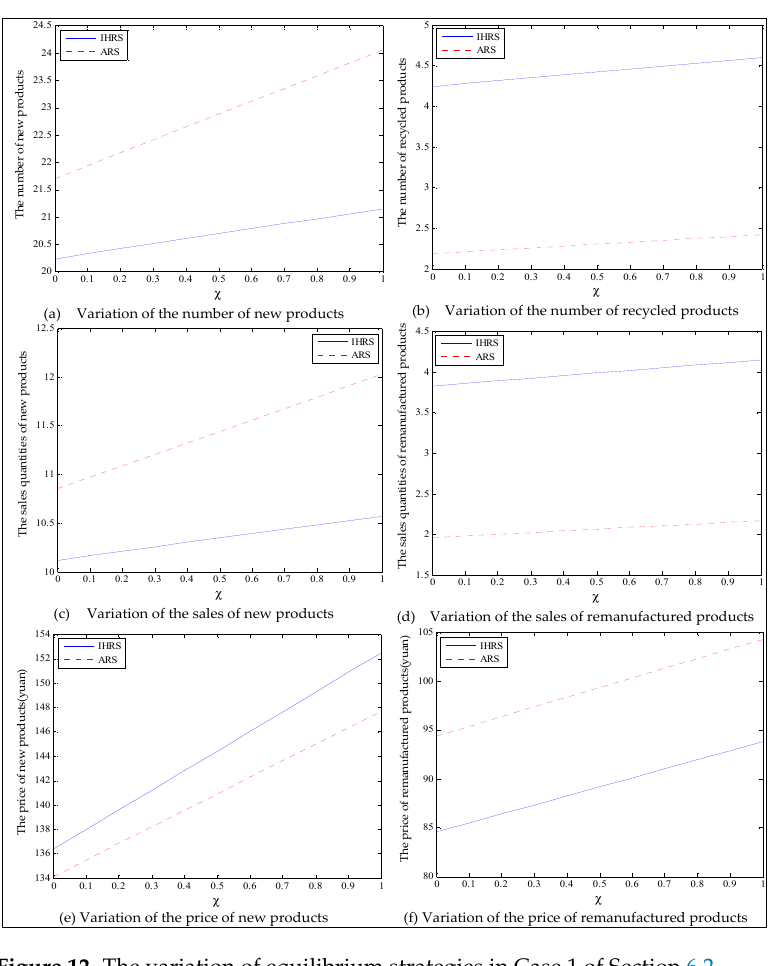
Figure 12. The variation of equilibrium strategies in Case 1 of Section 6.2.